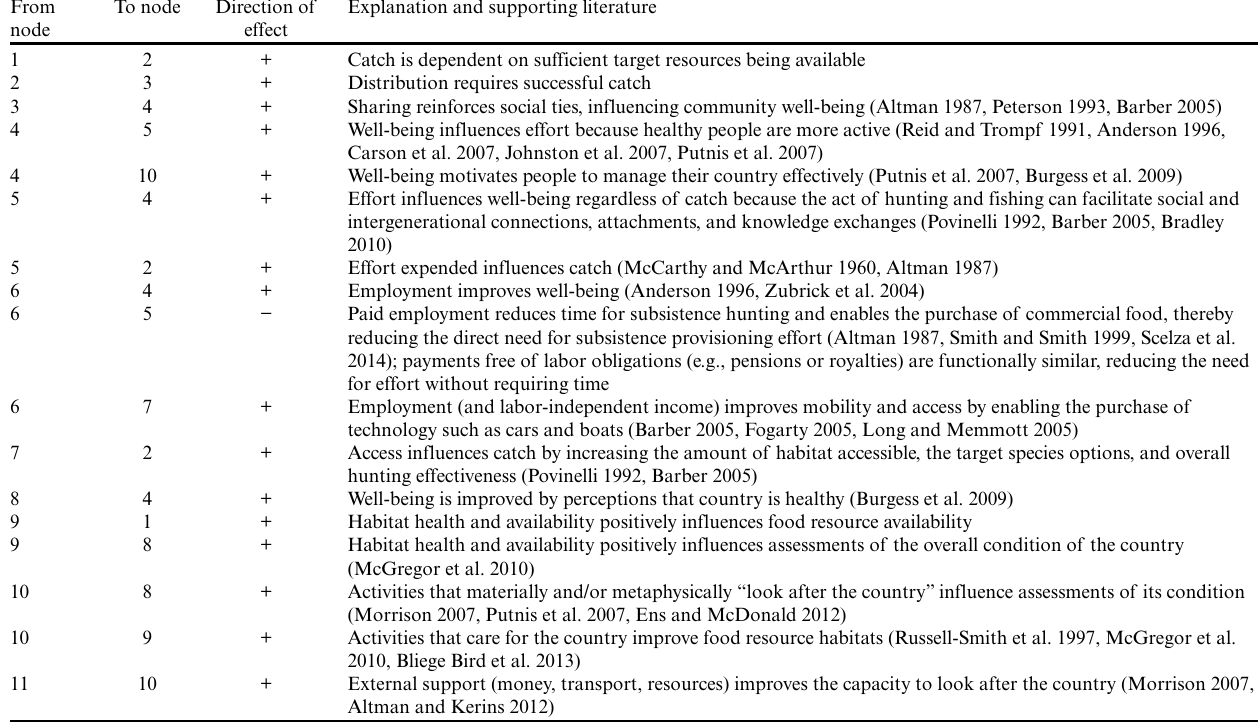
Table 2. Definition and explanation of links in model A.